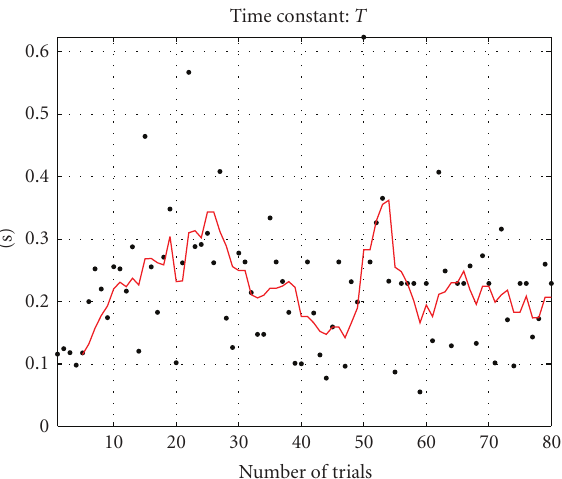
Figure 14: Change of identified T